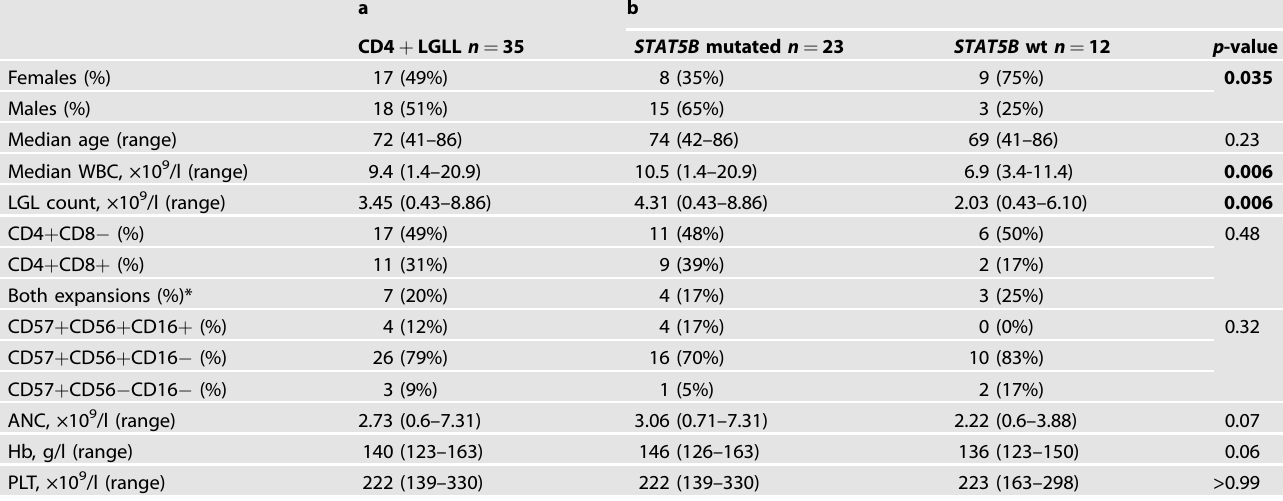
Table 2. Clinical features of the CD4 + T-LGLL